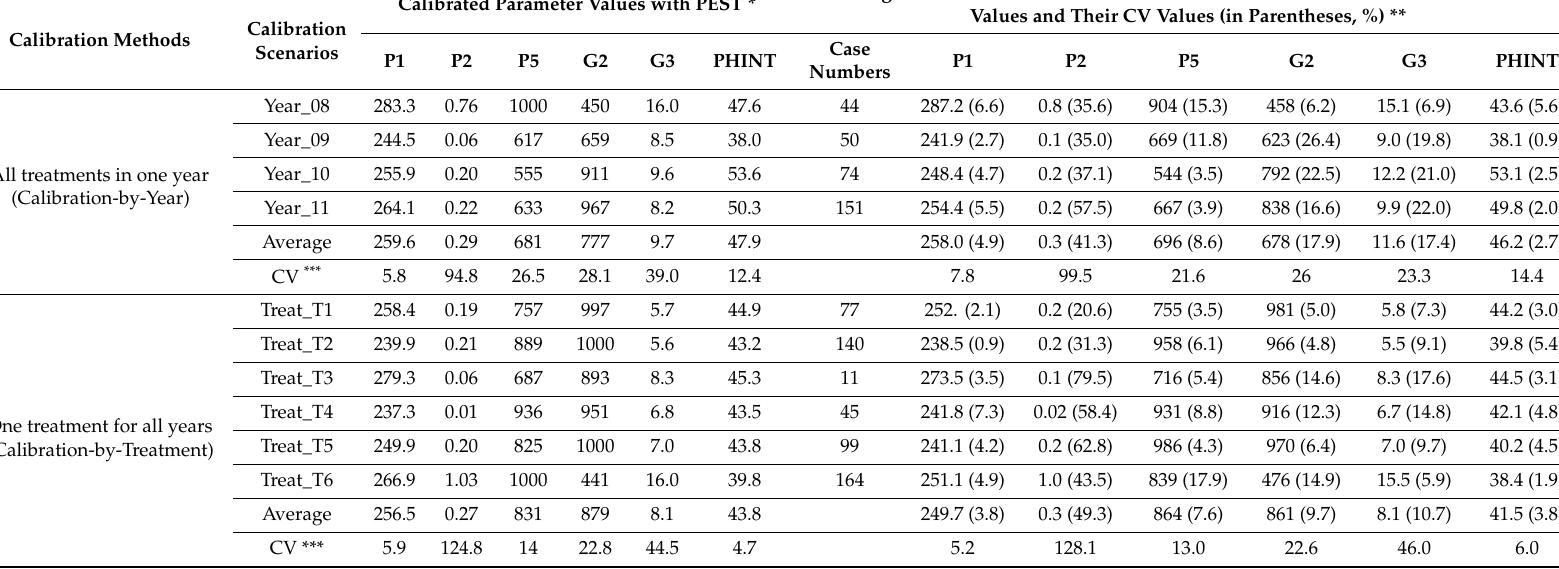
Table 3. Calibrated cultivar parameter values, and the averaged cultivar parameter values and their coe ffi cients of variation (CV, %) among the selected Φ cases (11–164 cases with Φ values within 10% of calibrated Φ values for each scenario) from the 300 cases generated by Latin hypercube sampling (LHS), for the Calibration-by-Year and